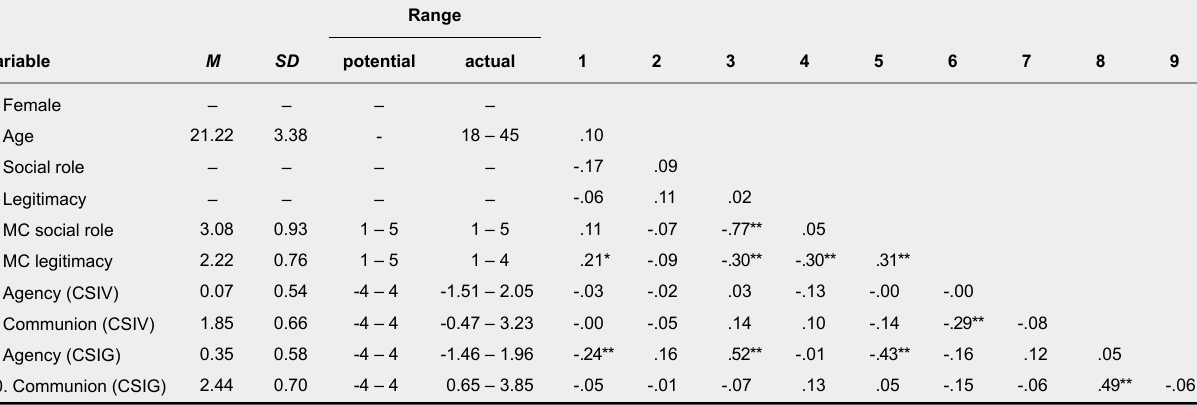
Descriptive Statistics and Bivariate Correlations Between the Independent and Main Dependent Variables Used in Study 2 (N =